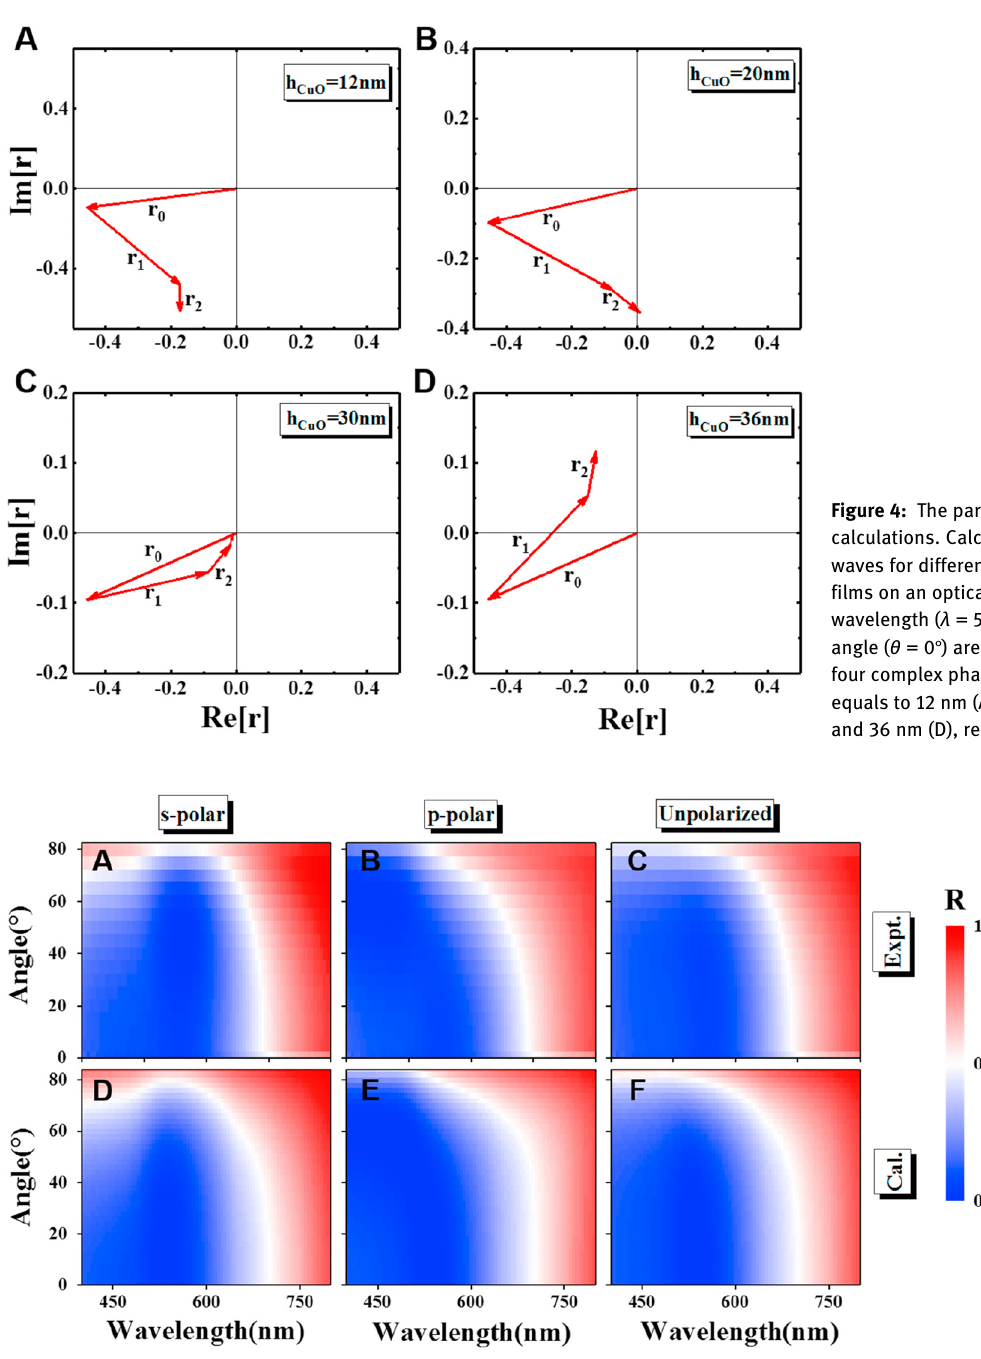
Figure5: Angularresponsesoftheopticalreflectionproperties.Experimental(A,B,C)andcalculated(D,E,F)reflectancespectraasafunction of the wavelength and incident angle for s , p , and unpolarized light, respectively. Here, h CuO = 30